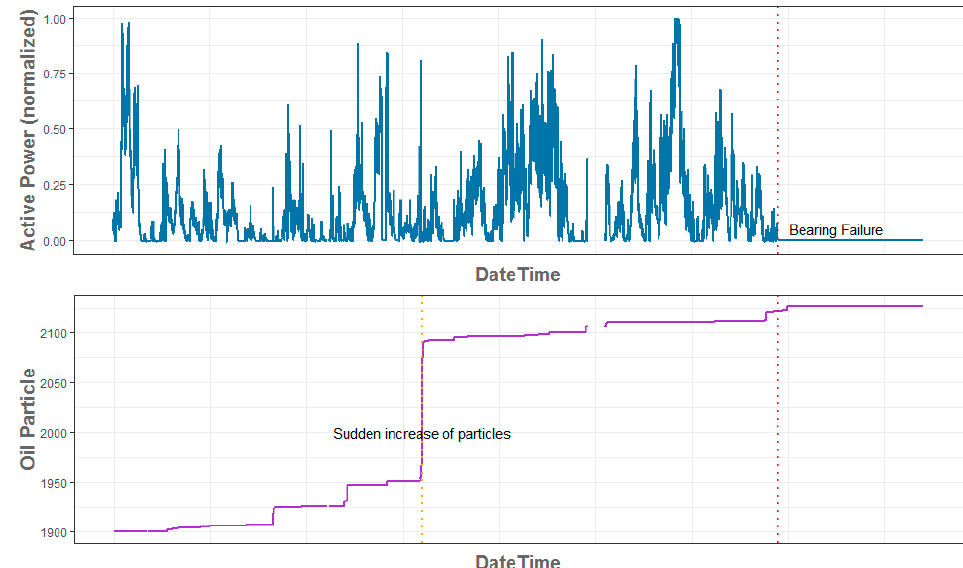
Figure 8. Oil particle based diagnostic of the drivetrain of the wind turbine used in this case study.